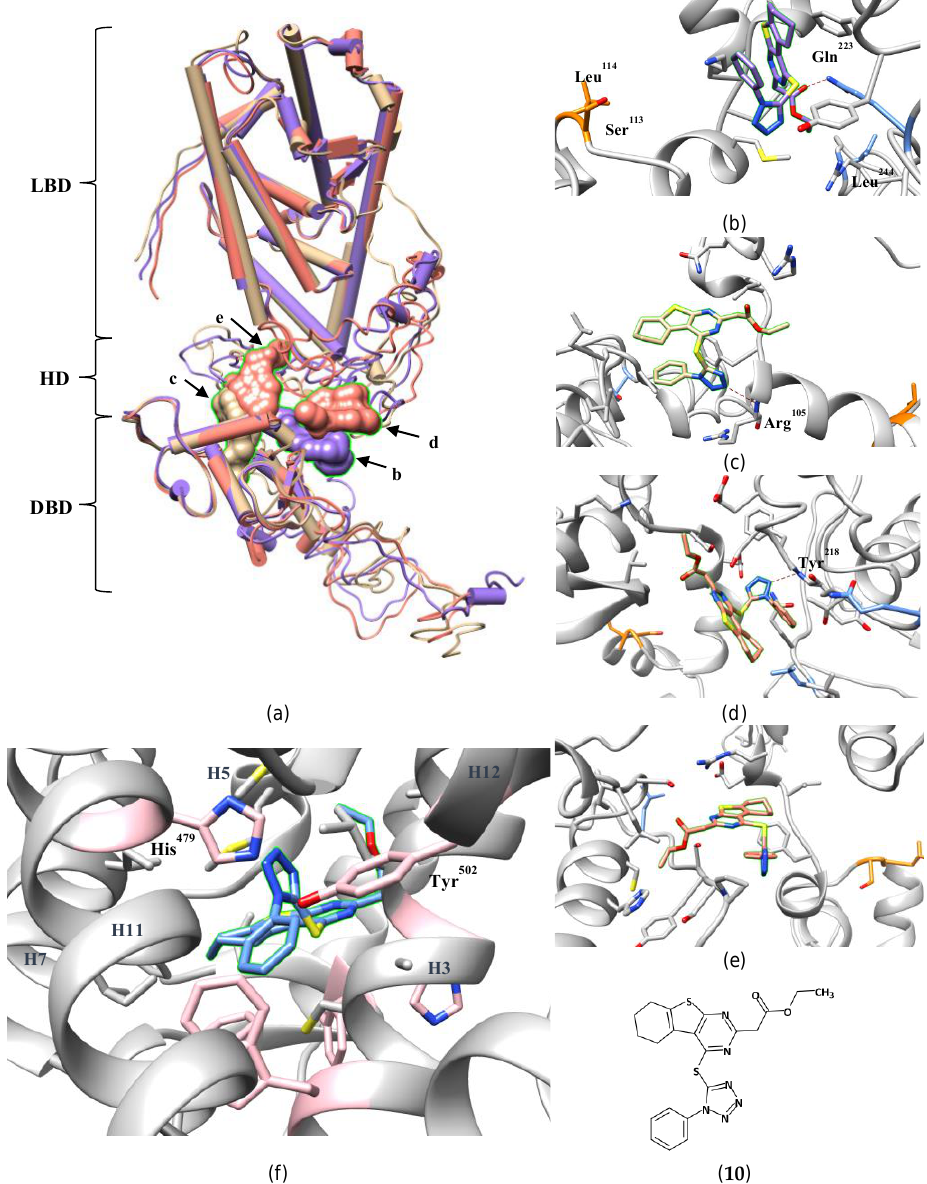
Figure 9. An inverse agonist ( 10 ) potentially binds in an allosteric pocket of ROR γ hinge domain (HD). The details of the full-length ROR γ homology models and molecular docking experiment were described in Supplementary Protocol S1. ( a ) The top-ranked poses of 10 docked against the HD site in three di ff erent homology models are displayed in purple, tan and salmon colors, respectively. The binding energy of the poses in the homology models was analyzed (Supplementary Table S5). ( b ) In the purple model, 10 poses at a position closed to Lao’s. It hydrogen-bonds to Gln 223 but stays far from Leu 244 . Ser 113 and Leu 114 are presented in orange color and Gln 223 and Leu 244 in light blue. ( c ) In the tan model, 10 shows no contact to Ser 113 , Leu 114 , Gln 223 or Leu 244 . ( c , d ) In the salmon model, two poses of 10 were docked in the site. None of them is closed to Ser 113 , Leu 114 , Gln 223 or Leu 244 . ( f ) 10 may bind in the orthosteric pocket of ROR γ LBD (PDB 4NIE) through π -stacking (pink) and hydrophobic (grey) interactions. It may contact the agonist lock. More details are shown in Supplementary Figure S3.